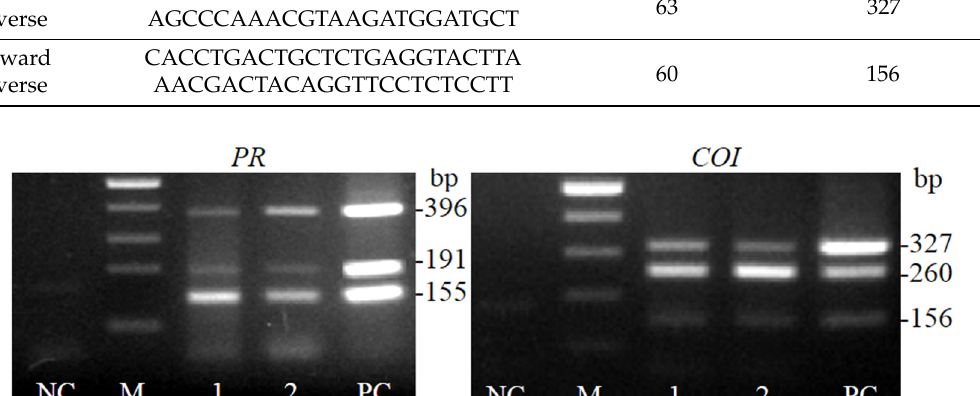
Figure 7. PCR products amplified with newly designed primer pairs specific to R. nigrum PR s, PR1, PR6 and COI1 genes. NC—negative control; M—size standard 100, 200, 300, 400, 500 bp; 1—cDNA of cv. Aldoniai; 2—cDNA of cv. Ben Tirran; PC—positive control.